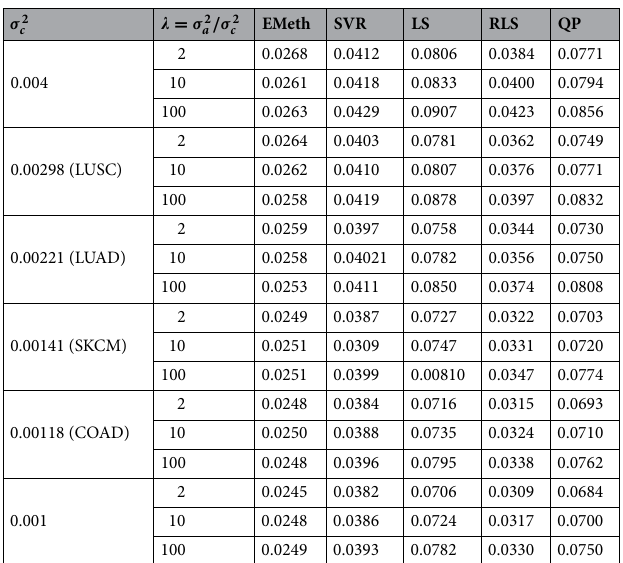
Table 1. Estimation results from a simulation study. Cell type proportion estimation accuracy, evaluated in terms of rooted mean square error (RMSE) for 18 simulation settings, with six values of σ consistent CpGs, and 3 values of (cid:31) , the ratio of the noise level between the aberrant CpGs and the consistent 2 CpGs. Four of the six values of σ c are selected according to estimation from four cancer types of the TCGA